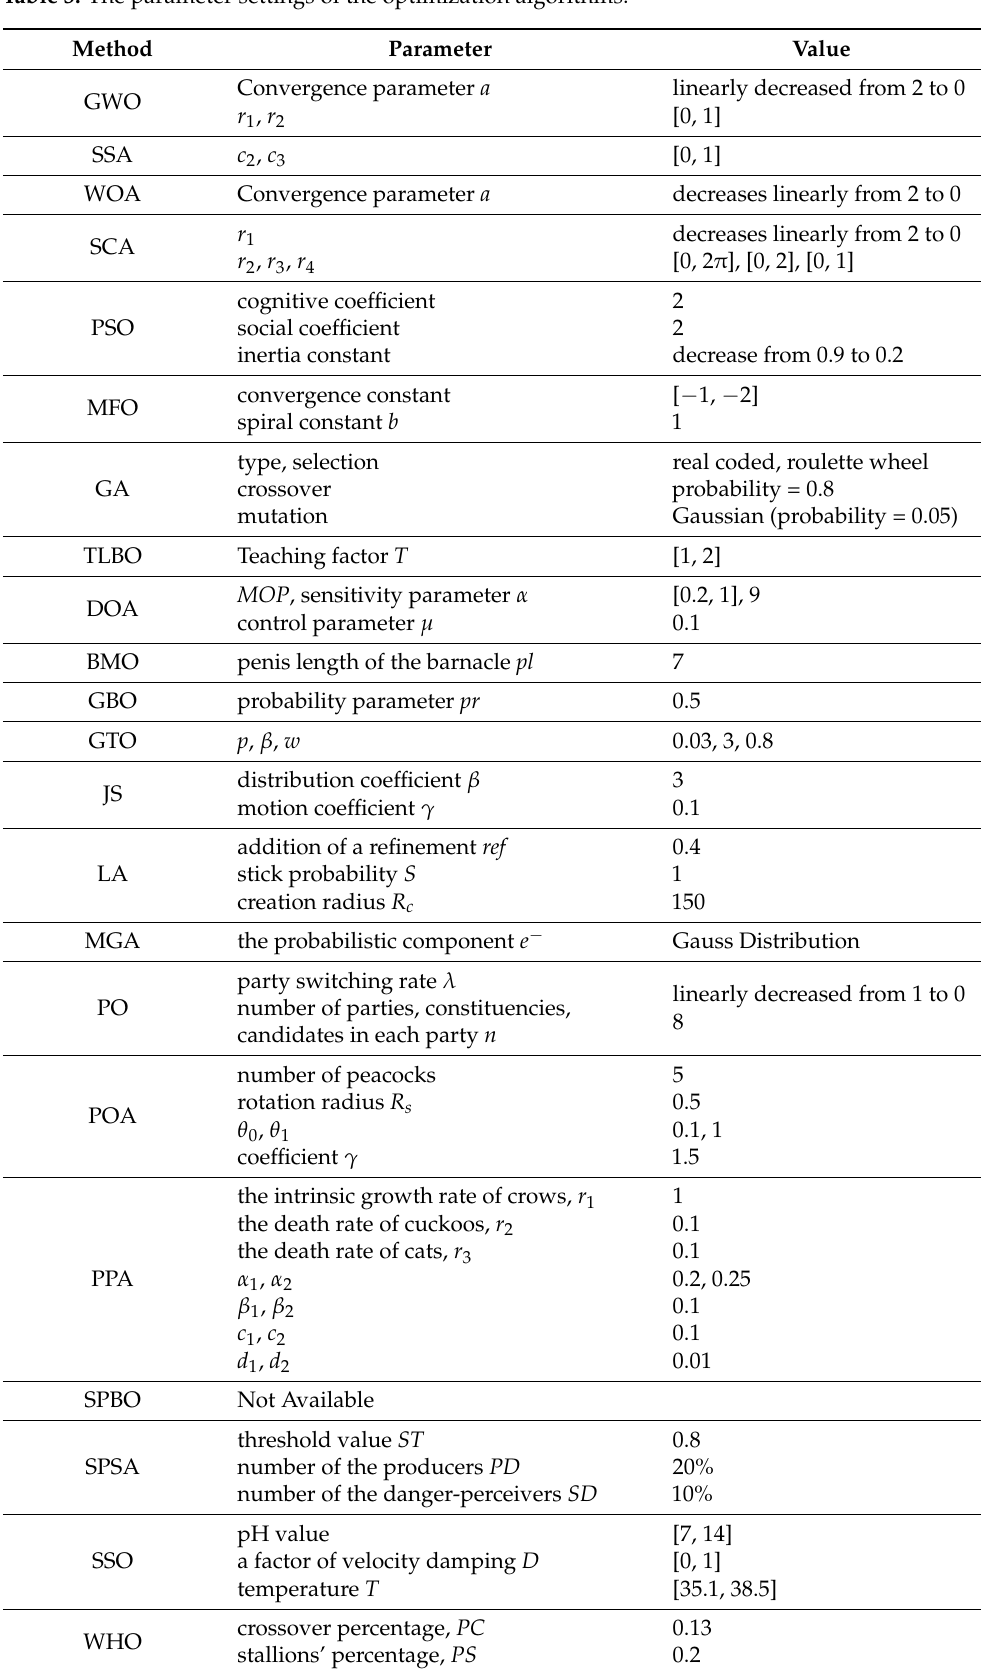
Table 3. The parameter settings of the optimization